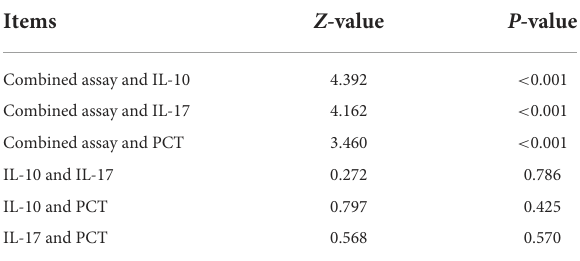
TABLE 3 Comparison of the AUC areas of IL-10, IL-17, PCT and IL-10 + IL-17 + PCT combined assays.